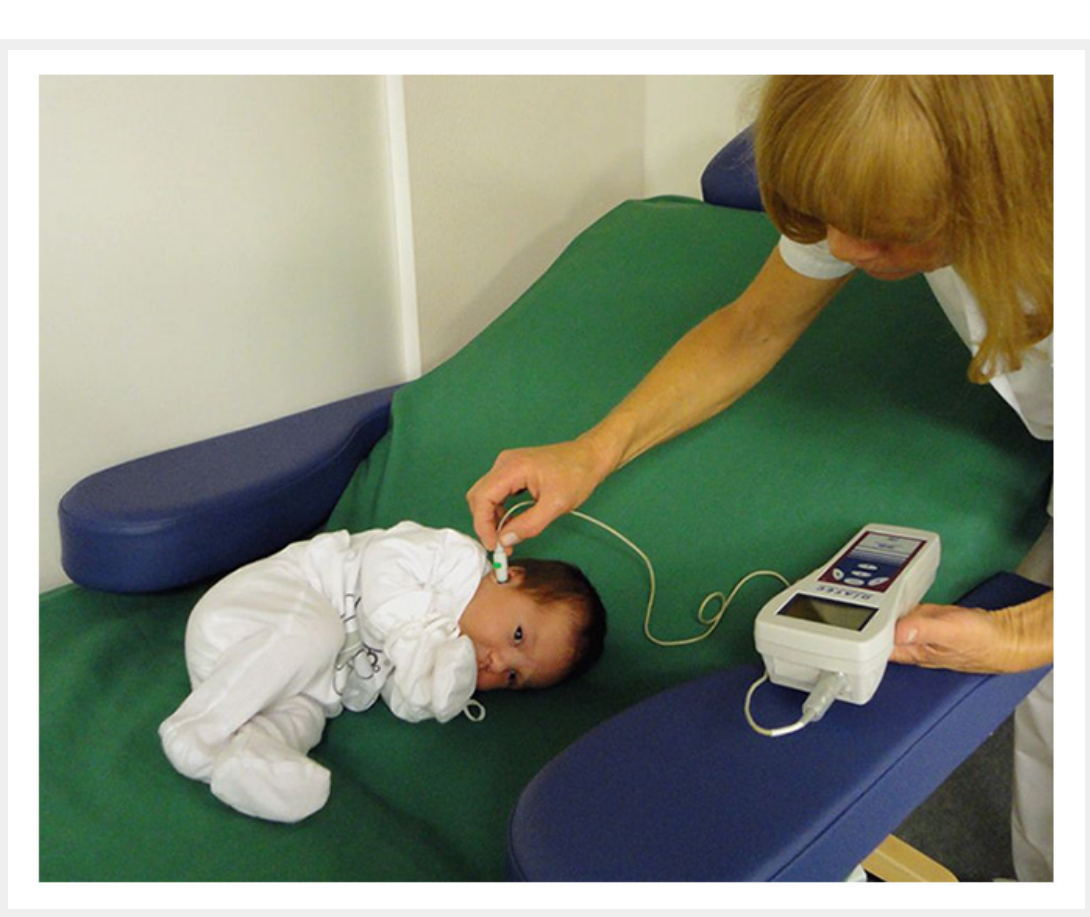
Figure 1 Newborn hearing screening with measurement of automated